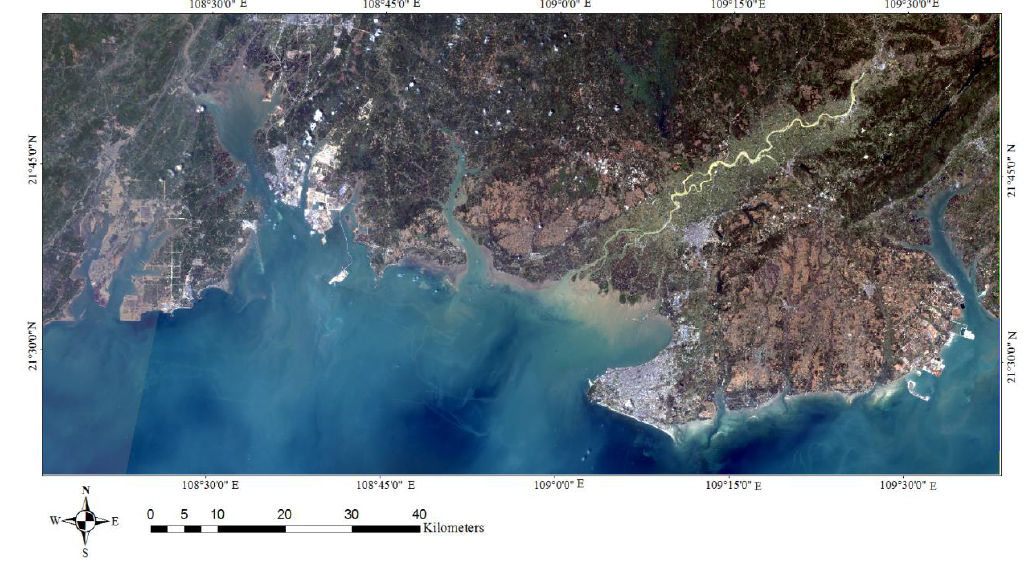
Figure 1. GF-1 WFV image of Beibuwan Gulf acquired on April 1st,